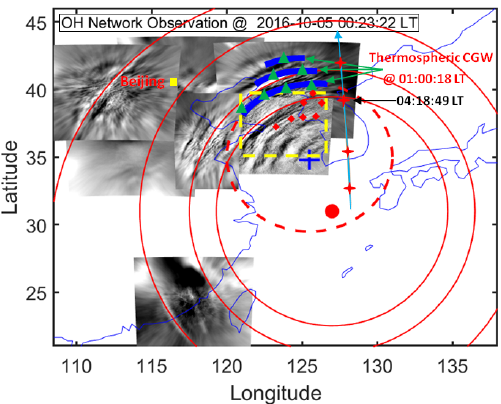
Figure 9. Double-layer CGW-superimposed graph. The blue arcs represent the thermospheric CGW observed at 01:00:18LT. The dotted circle represents the approximately fitting blue arcs. The blue cross marks the centre of the circle. The solid circles represent the approximately fitting CGWs observed by the OH airglow network. The red dot marks the centre of the circles. The green triangles and red diamonds represent the trace start and termination points, respectively. The red crosses represent the sounding footprints of the TIMED–SABER (Thermosphere Ionosphere Mesosphere Ener- getics and Dynamics satellite’s Sounding of the Atmosphere using Broadband Emission Radiometry instrument) measurements. The yellow box marks the location of the meteor radar